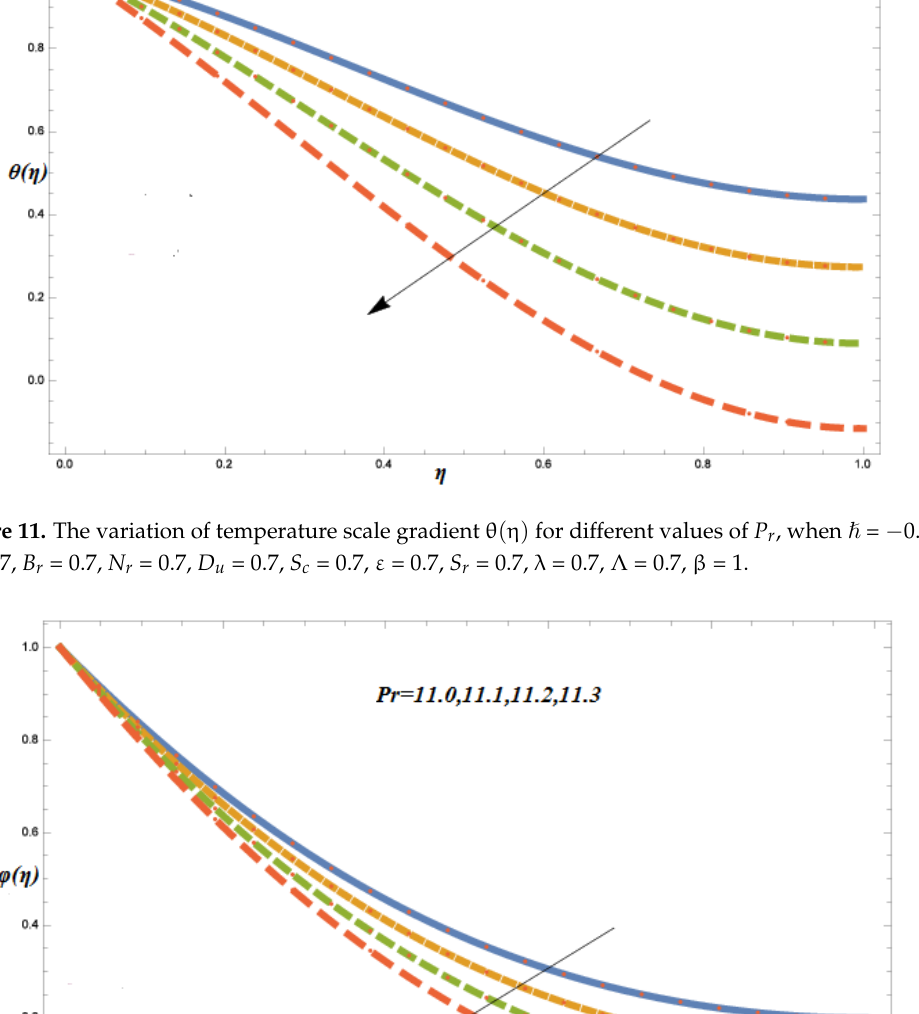
Figure 10. Variation in velocity field ( ) f  for various values of P r , when  = − 0.25, D u = 0.7, S c = 0.7, λ = 0.7, Λ = 0.7, β = 1, S = 0.7.